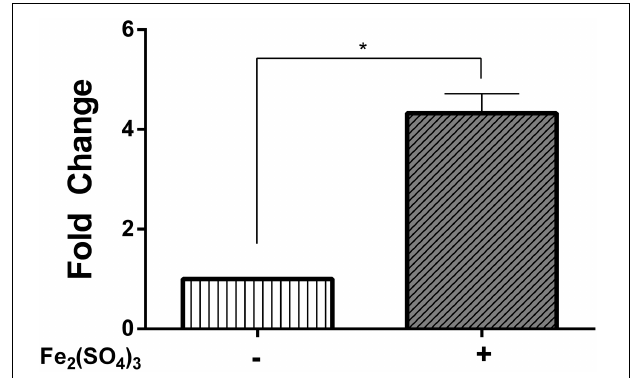
FIGURE 6 | Relative mRNA levels of the cbiA gene in Leptospirillum CF-1. Bacteria were treated with 260 Fe 2 (SO 4 ) 3 for 30 min. Data were normalized by the 16S rRNA. Data represent the average of two independent experiments (bar indicates the value range). ∗ P <